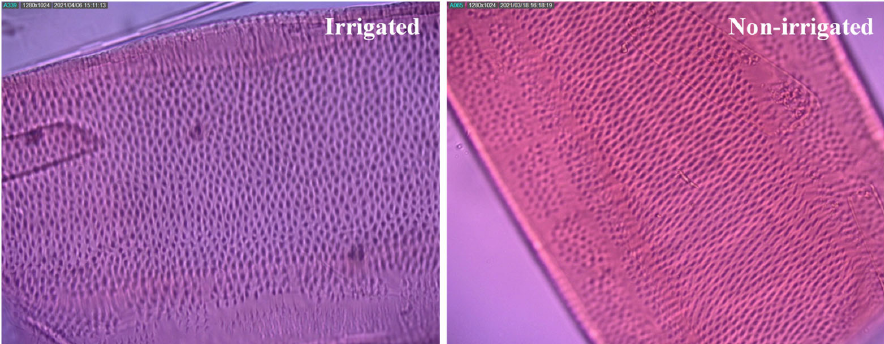
Figure 2. Detail of secondary wall thickening on light electron microscopy, along the superficial area of the vessels of Khaya grandifoliola .